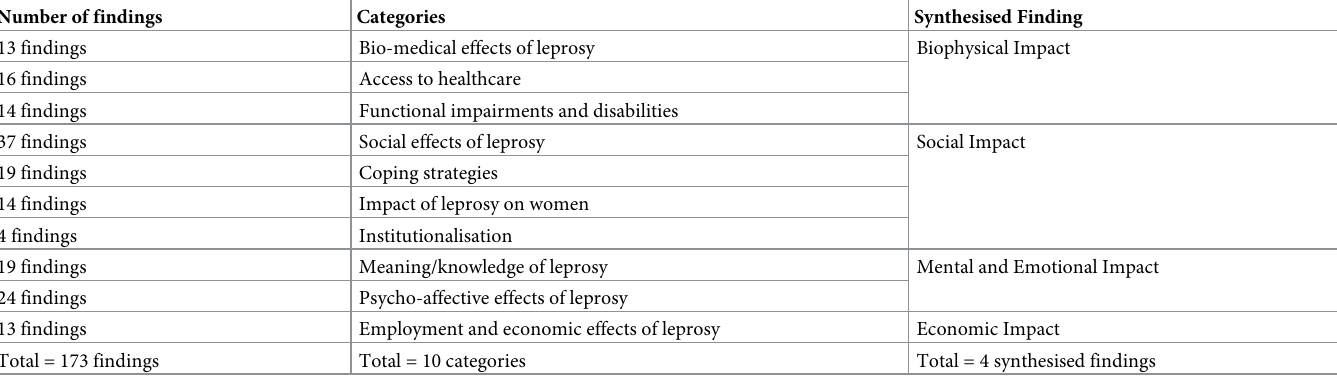
Table 5. Summary of findings and categories for each synthesised